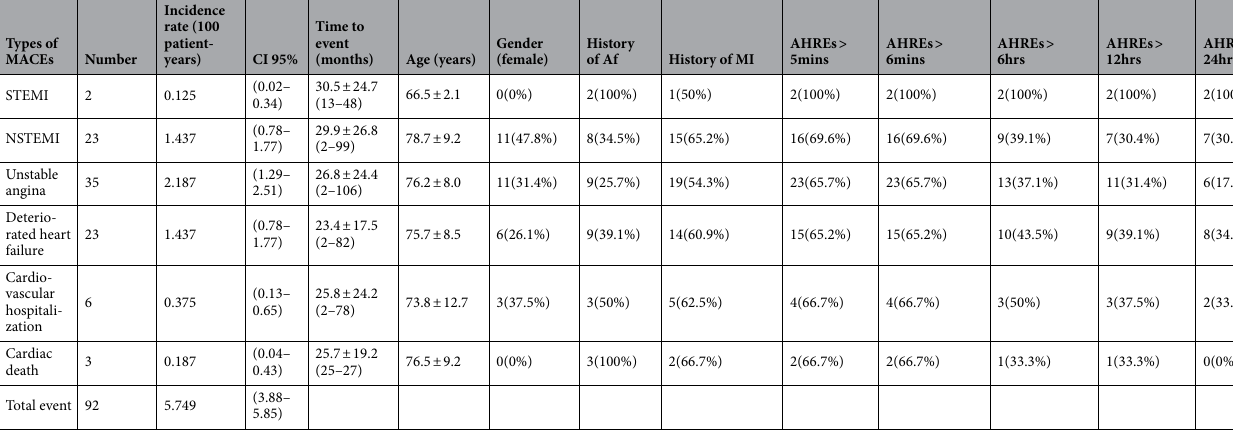
Table 2. Type and incidence of MACEs in the whole cohort. Data are presented as mean ± SD or n (%). Af atrial fibrillation, AHREs atrial high-rate episodes, CI confidence intervals, MACEs major adverse cardiac events, MI myocardial infarction, NSTEMI non ST-elevation myocardial infarction, STEMI ST-elevation myocardial infarction.